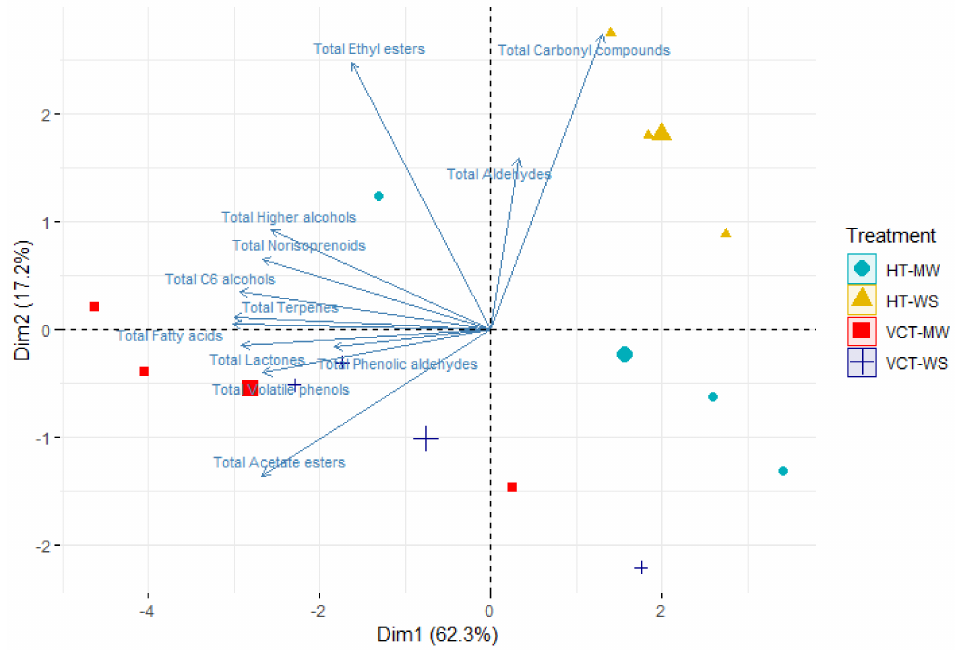
Figure 3. Principal component analysis (PCA) based on chemical families of volatile compounds determined in Maturana Blanca wines under different